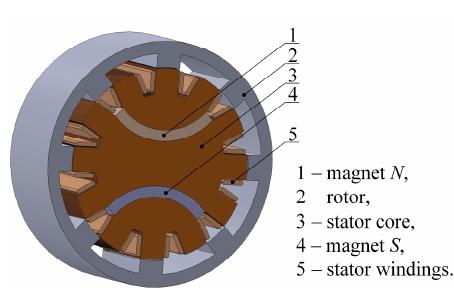
Figure 2. DSPM machine with external rotor.